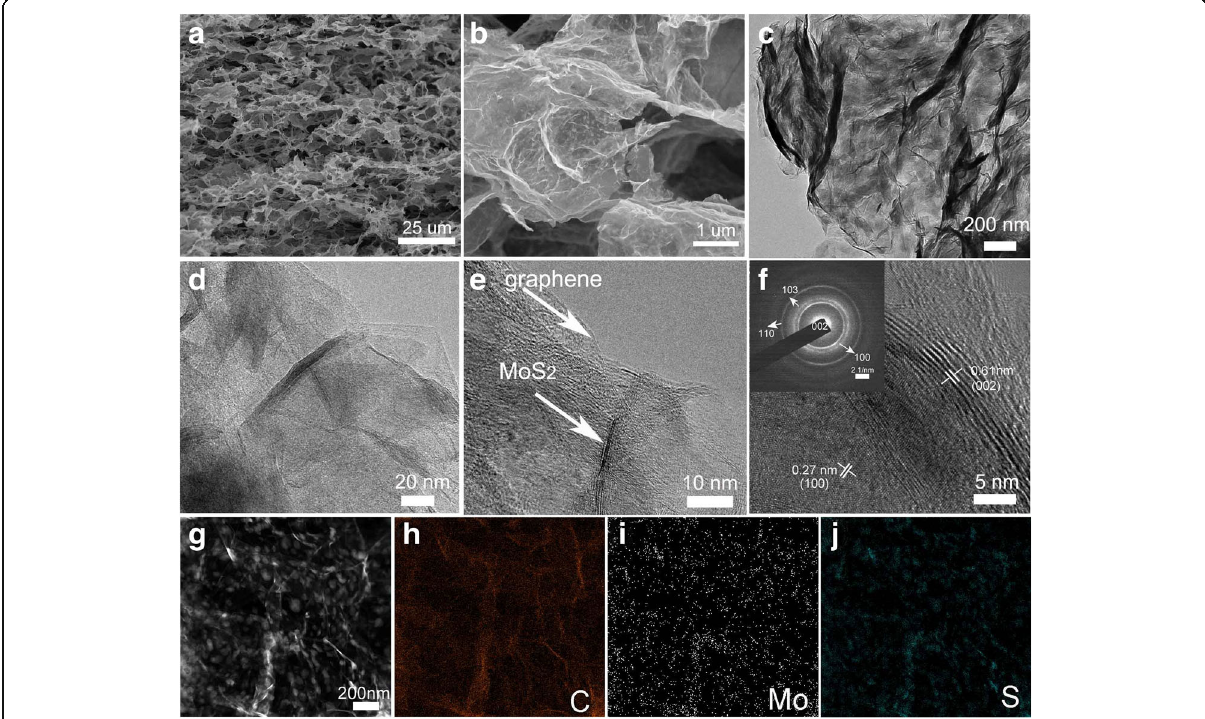
Fig. 2 a , b SEM images and c , d , e , f TEM and HRTEM images of the MoS2/RGO sample. g – j TEM-EDX mapping of Mo, S, and C elements. The inset in f is the corresponding SAED